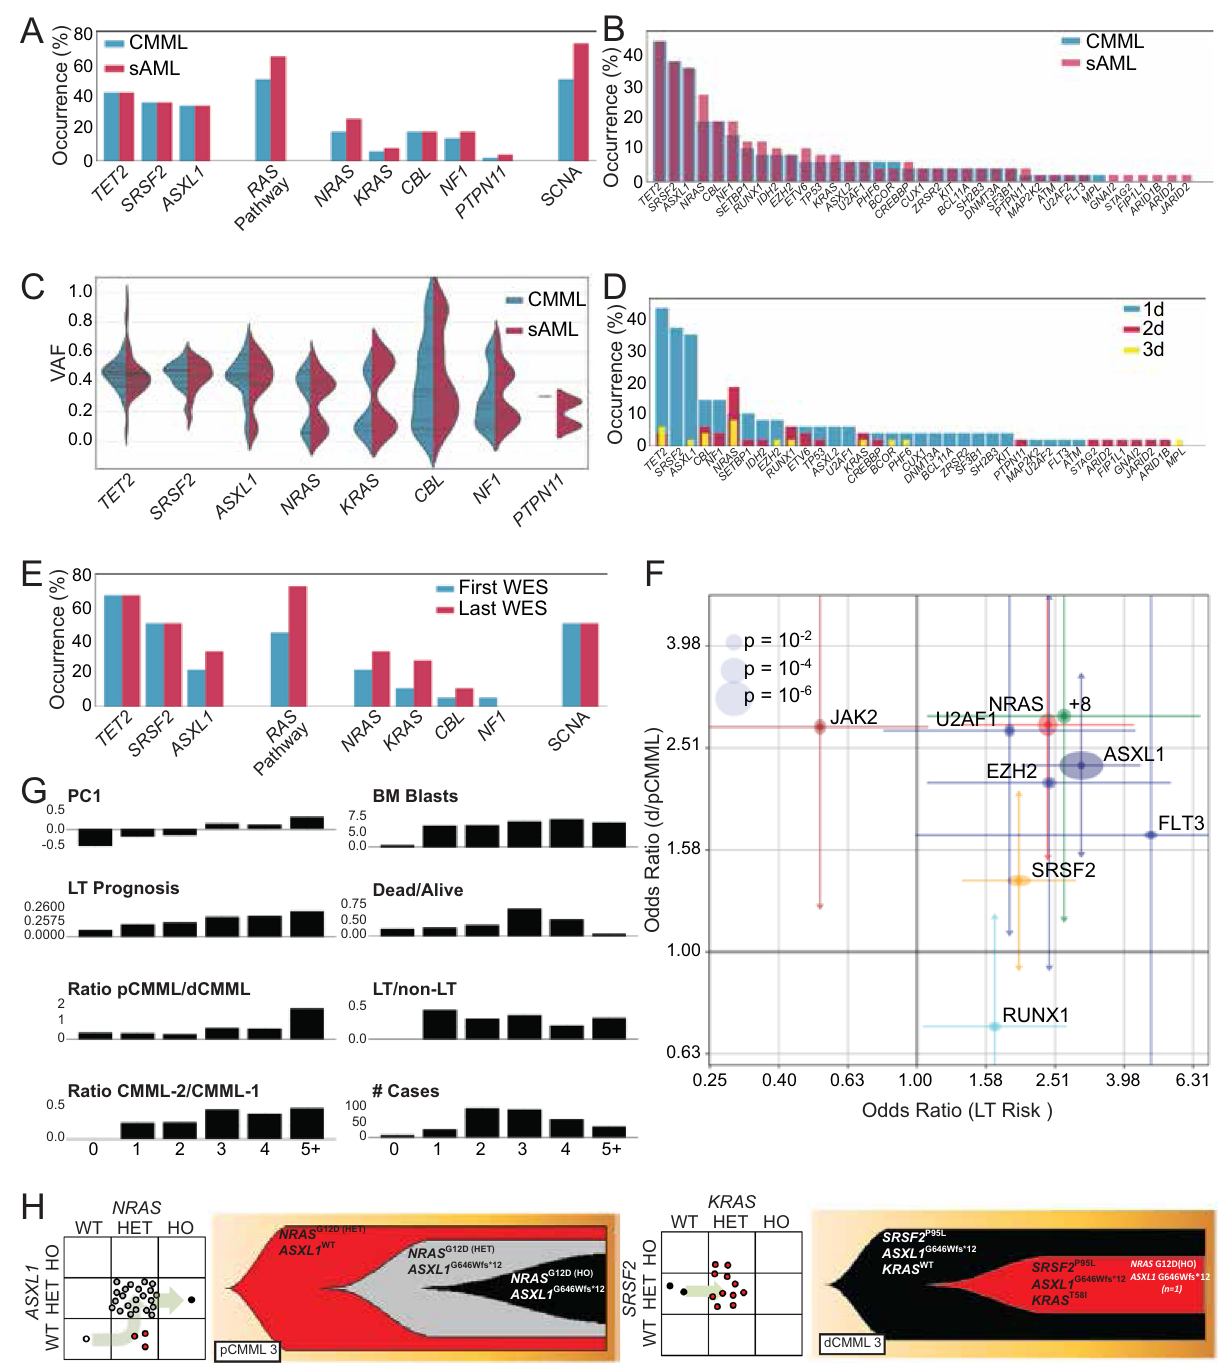
Fig. 2 Alterations in driver mutation pro fi les delineate stages of CMML progression. Whole exome analysis of 48 paired CMML and secondary AML (sAML) samples. A Prevalence of driver mutations and somatic copy number alterations (SCNAs) in CMML and sAML. RAS pathway represents all mutations in MAPK pathway. B Frequency of driver mutations and SCNAs in CMML and sAML. C Violin plots depicting variant allele frequencies (VAFs) for the most frequent driver mutations in CMML and sAML. D Frequency of driver mutations and SCNAs in CMML and sAML and their categorization as 1d, 2d, or 3d. E Genetic pro fi ling of CMML evolution in eighteen patients at two time points by whole exome sequencing. F Odds ratios of genetic factors selected by the L1-regularized logistic regressions that have the greatest impact on dysplastic/proliferative CMML categorization and leukemic transformation (LT) risk. The x -axis represents odds ratios of LT risk (high or low). The y -axis represents categorization of low or high white blood cell (WBC) count, or pCMML vs dCMML classi fi cation. The horizontal and vertical size of ellipses re fl ects corresponding p -values calculated by two-tailed Fisher ’ s exact test. Additionally, con fi dence intervals ( ɑ = 0.05) of odds ratio values are presented. The mean is the measure of center. G Strati fi cation of parameters associated with aggressive disease phenotype by number of driver mutations. H Fish plots derived from patient-derived single colony assays of representative cases of pCMML (left) and dCMML (right). Scatter plot to the left of each fi sh plot represents the genotype of individual colonies as determined by Sanger sequencing of the indicated genes. RAS mutation status is depicted on the x -axis. The arrow indicates inferred evolutionary trajectory from which the fi sh plot was